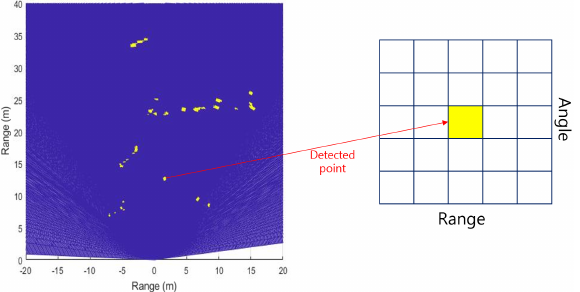
Figure 10. RA data matrix of detected point after